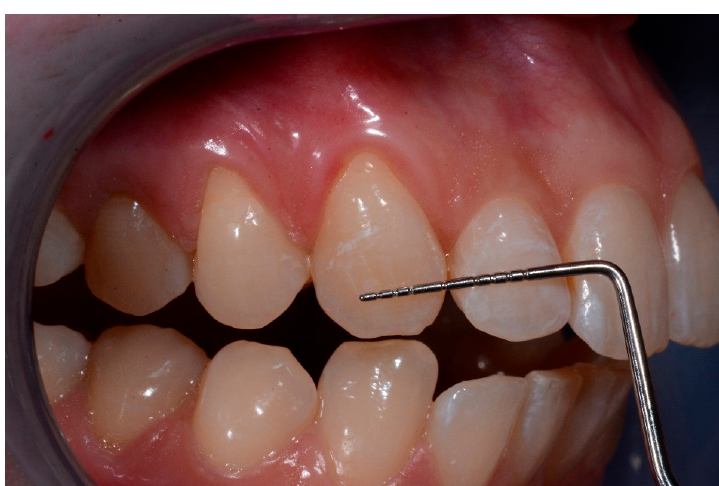
Figure 8. t2 lesions. Figure 4. Baseline lesions. Figure 6. t1 lesions.